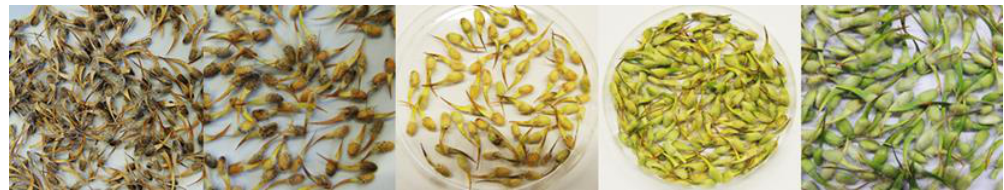
Figure 14. Pod maturity stages in B. bituminosa . From left to right: BD = brown dehydrated, BH = brown hydrated, Y = yellow, GY = green yellow and GF = green full pods.